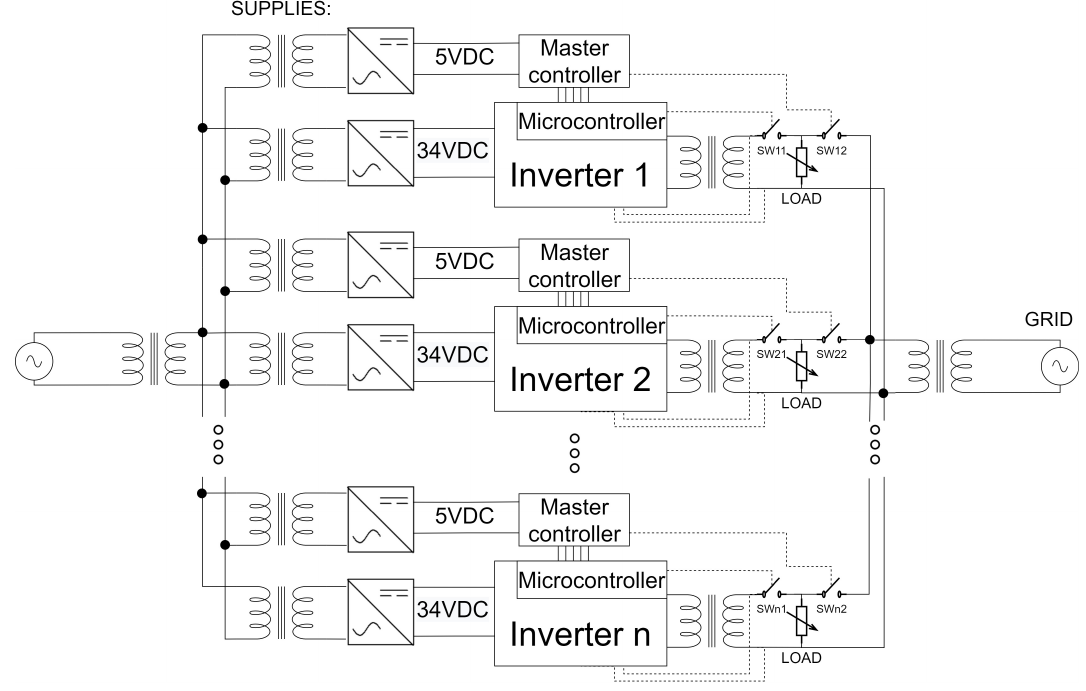
Figure 4. Block diagram of testing circuit.